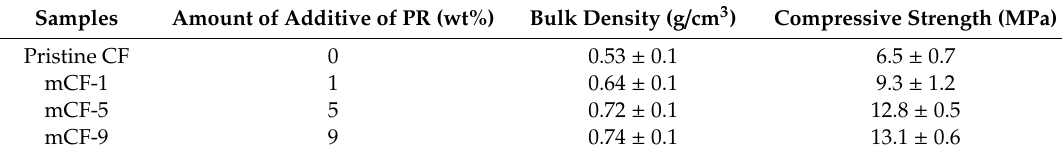
Table 3. Summaries of bulk density and compressive strength of the pristine CF, mCF-1, mCF-5 and mCF-9.